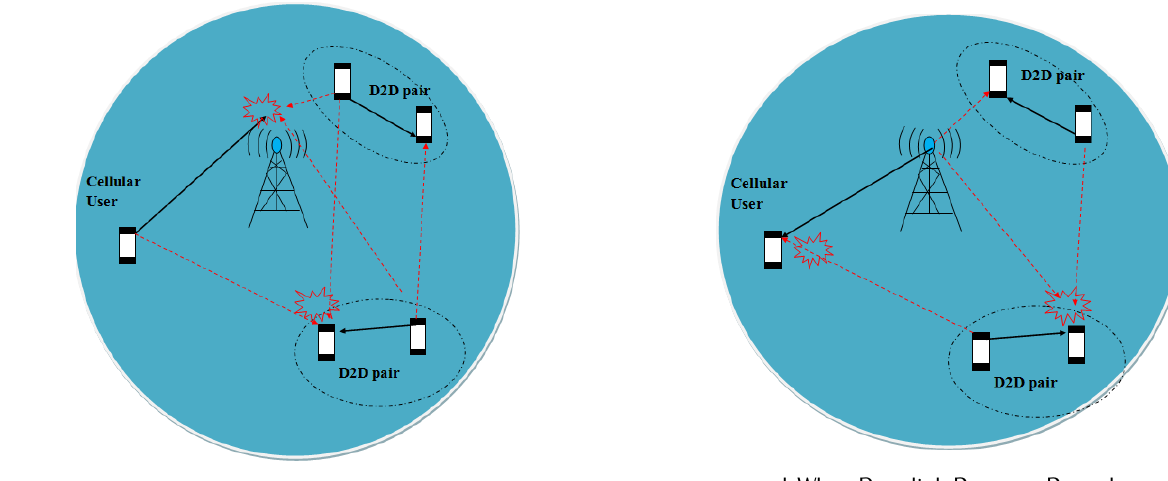
b.When Downlink Resource Reused. Figure 6. Interference in D2D communication.